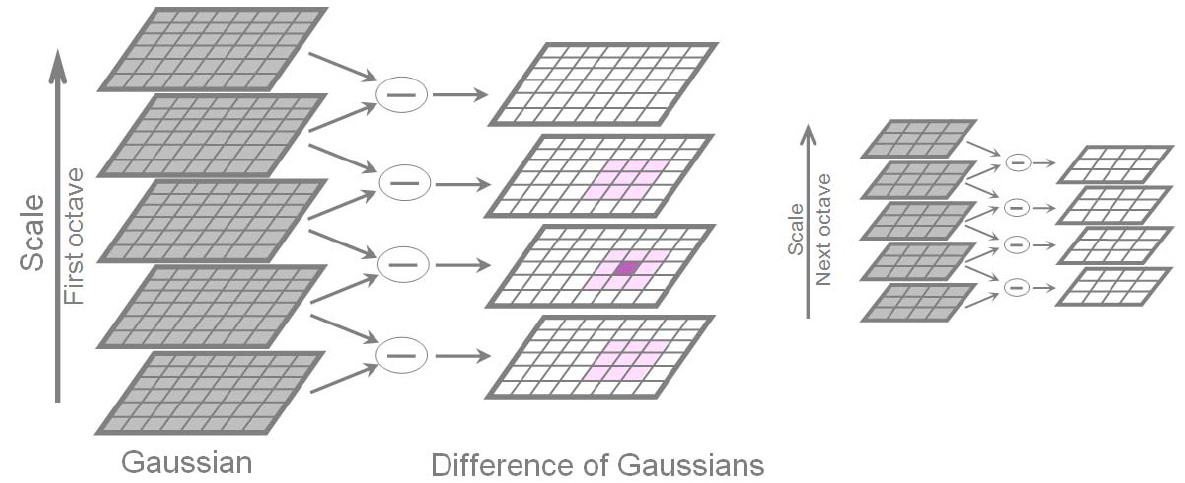
Figure 1. Creation of octaves and Difference of Gaussians (adapted from